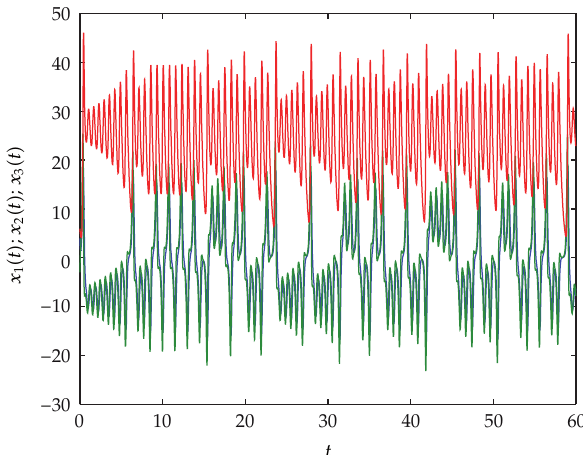
Figure 1: Typical state trajectories of the system (cid:3) 2.1a (cid:4) – (cid:3) 2.1d (cid:4) with a (cid:8) 0 . 4.